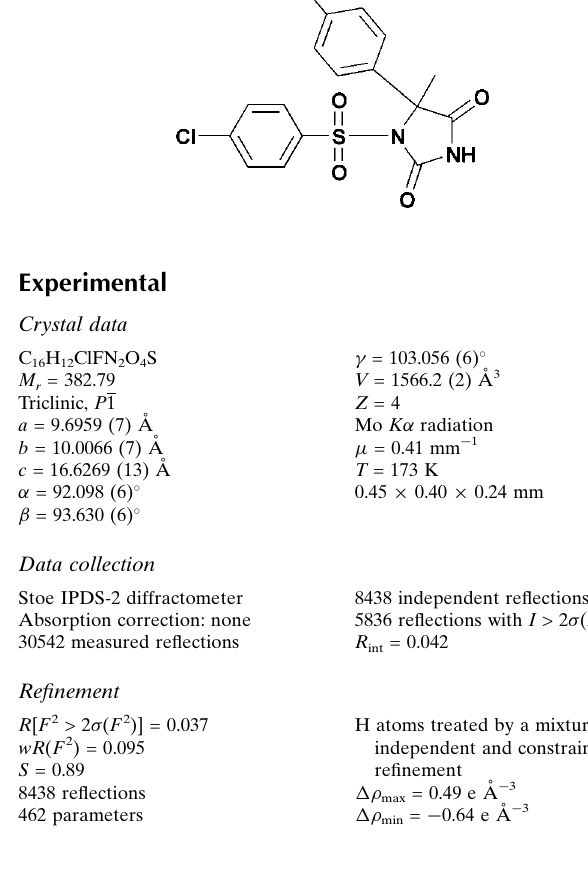
The title compound, C